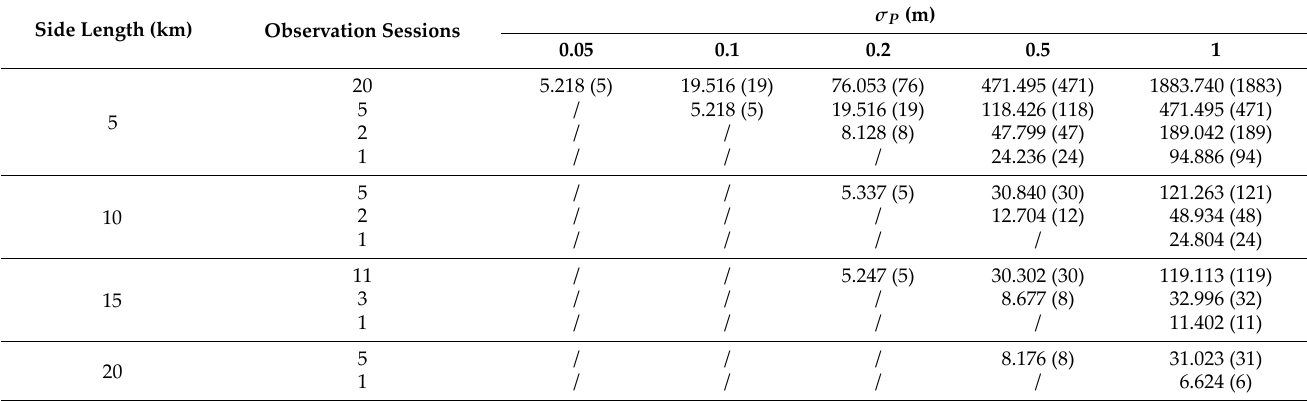
Table 5. The position of the weakest point under different side lengths and observation sessions when the number of the equilateral triangle unit network is odd.